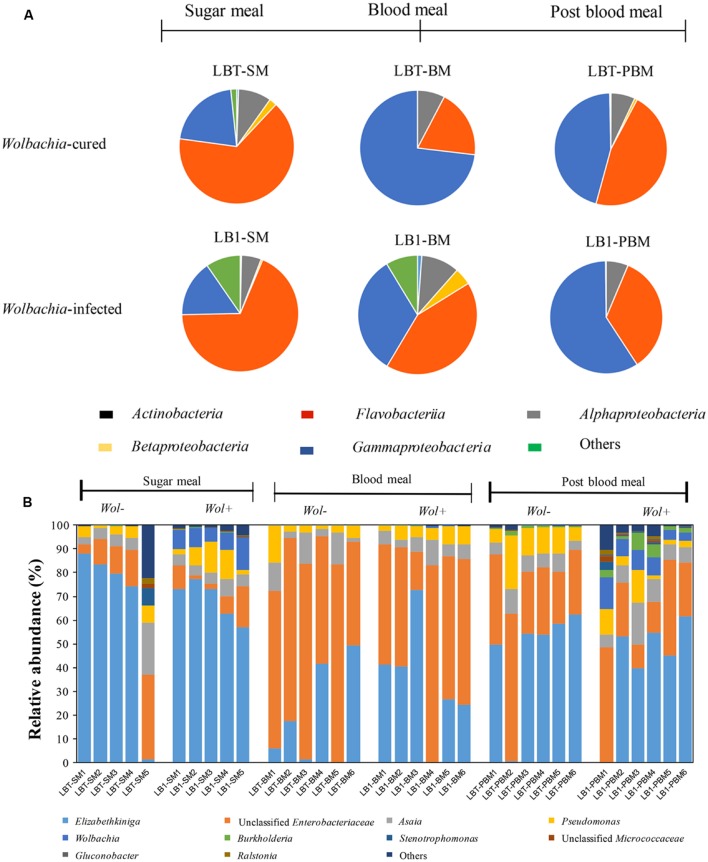
Gut bacterial composition at class level and the relative abundance of the top 10 genera in Wolbachia-infected and Wolbachia-cured mosquito samples by dietary treatment.
(A) Taxonomic classification of bacterial reads retrieved from the Wolbachia-infected and Wolbachia-cured mosquitoes. (B) Relative abundance of 10 most abundant OTUs (97% similarity). Unclassified Enterobacteriaceae or Micrococcaceae represent the reads that were assigned to the family Enterobacteraceae or Micrococcaceae, but could not be assigned to a genus. Wol+, Wolbachia-infected mosquito; Wol-, Wolbachia-cured mosquito.